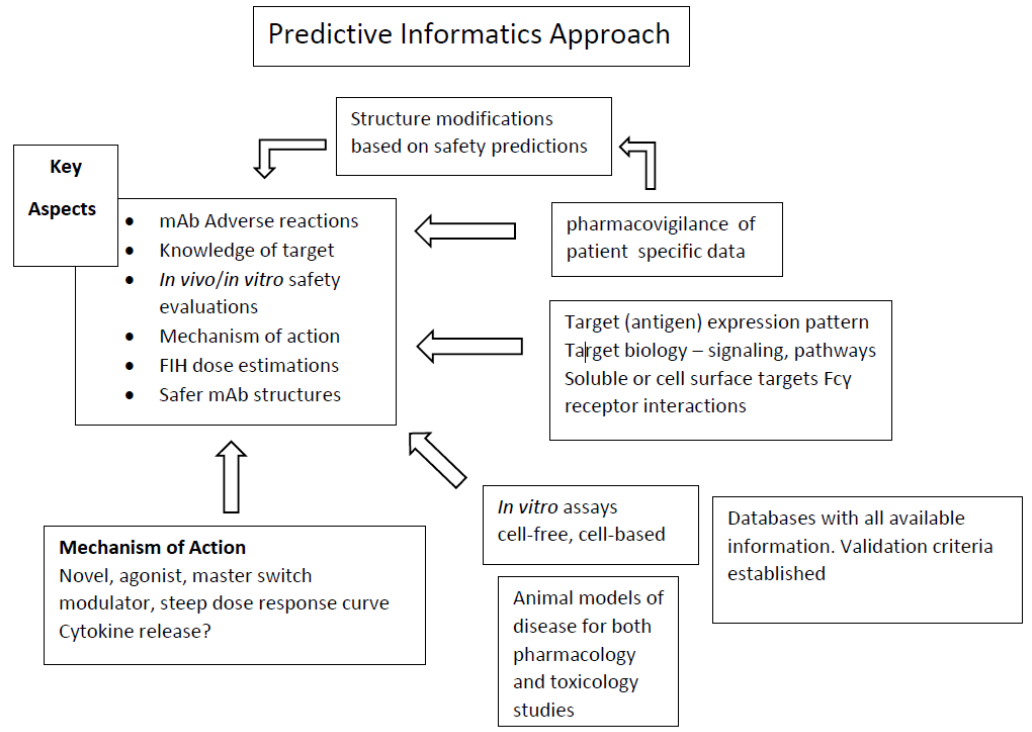
Figure 1. Informatics Approach for Predictive Toxicology of Monoclonal Antibodies. Informatics processing of several data sources to create a predictive tool for identifying Key Aspects during mAb research and development.